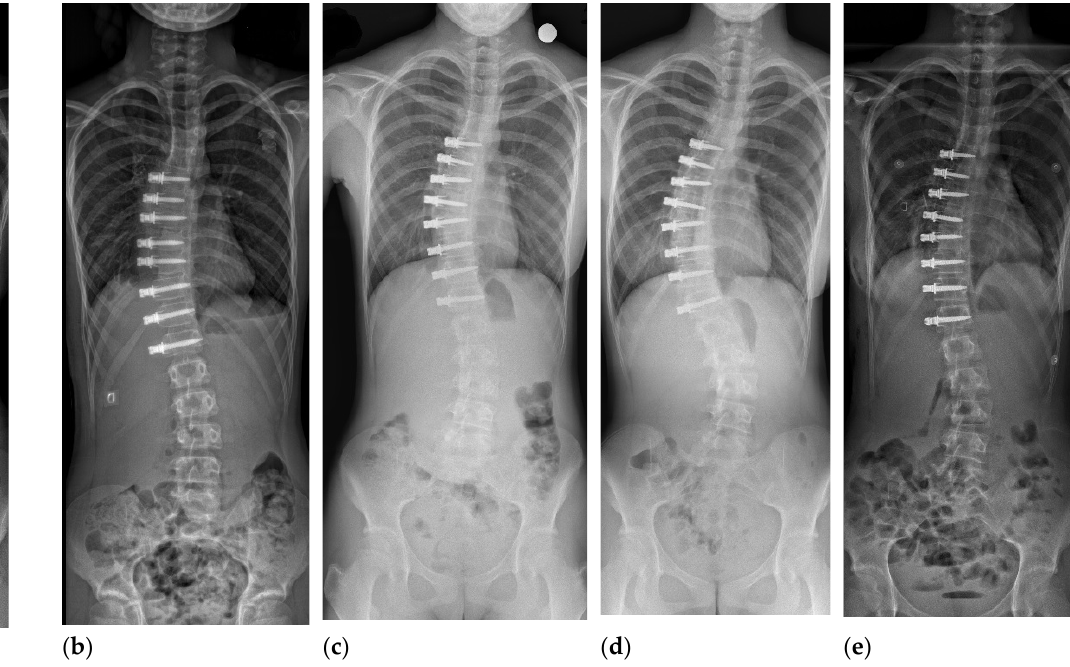
Figure 1. 12 year-old girl, Sanders 2, Lenke 1 AN curve of 50 degrees ( a ). First erect postoperative radiograph ( b ), 1 year follow-up ( c ), 30 month follow-up demonstrating splaying of the screw heads at multiple levels and progression of the deformity ( d ), and after revision surgery (Sanders 6) for replacement of broken tether ( e ).